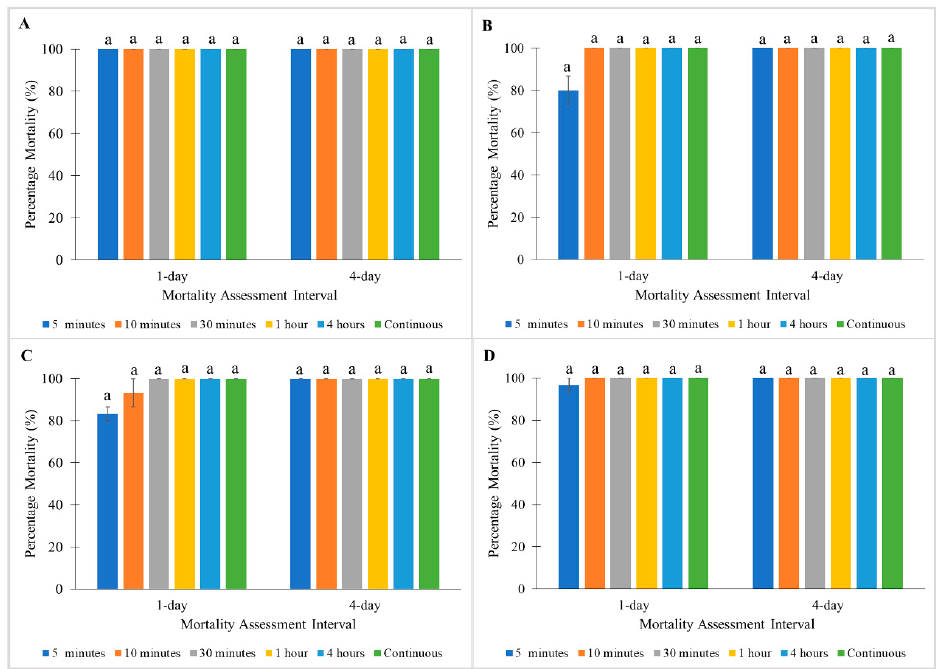
Figure 1. Influence of exposure time on Tandem on percentage mortalities of a susceptible C. lectularius strain and three C. hemipterus strains at 1 and 4 days post-treatment. ( A ) Monheim, ( B ) Madam Mo, ( C ) Tanjong Tokong, ( D ) Green Lane strains. Bars with different letters are significantly different (Kruskal–Wallis test, p < 0.05).